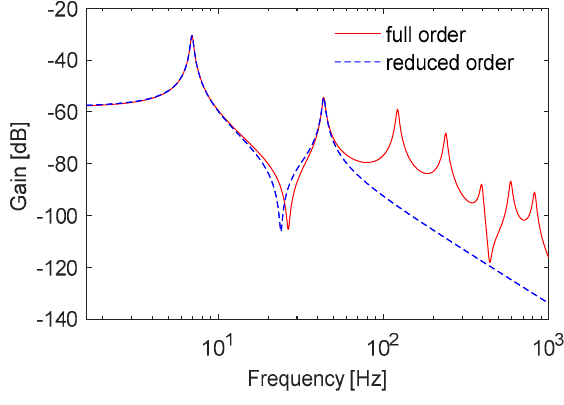
Figure 5. Frequency response of the blade state space models.